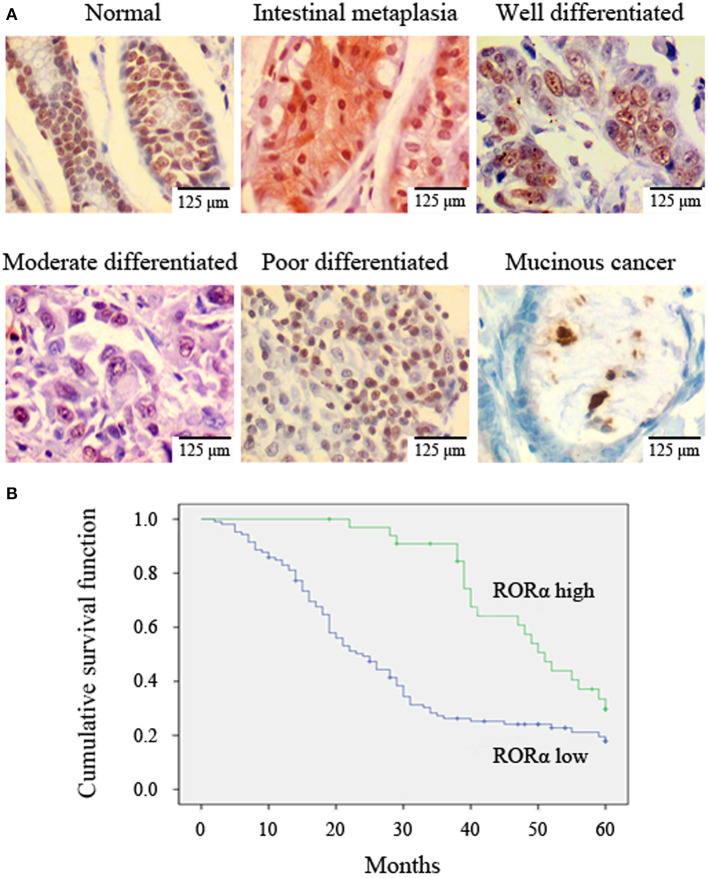
Retinoid-related orphan receptor alpha (RORα) expression is correlated with histological grade and survival probability. (A) RORα expression in normal mucosa, intestinal metaplasia, and gastric cancer (GC) was detected by immunohistochemistry (IHC). A representative image is shown (×400 magnification). (B) Decreased RORα expression was correlated with poor overall survival. The overall survival curves for patients with low or high RORα expression are shown.